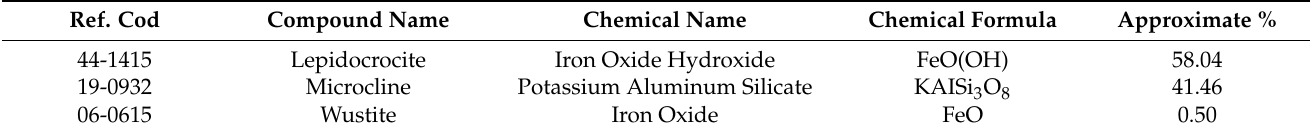
Table 1. Minerology composition of soil sample using XRD analysis.